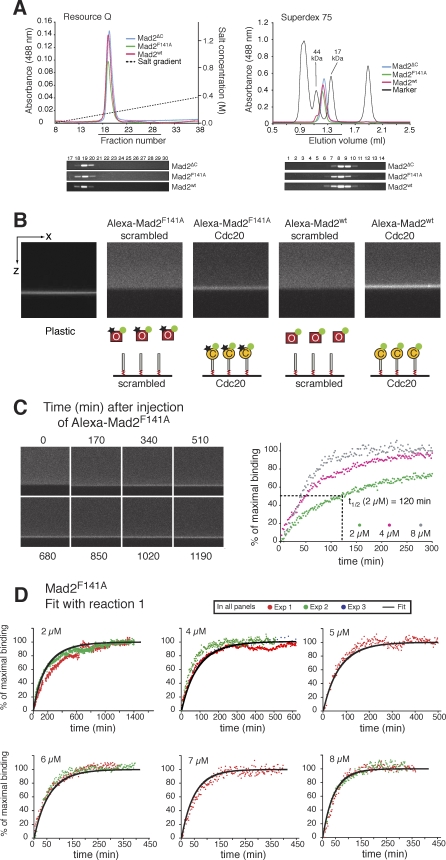
Kinetic Analysis for Rate Constants Determination of Mad2F141A
(A) The different Mad2 species used in the analysis retained their O-Mad2 conformation (left) and monomeric state (right) after covalent labelling with Alexa Fluor 488. After SDS-PAGE separation, the Alexa-labelled species were visualized under a UV transilluminator.(B) A flow chamber was built in which a biotinylated Cdc20 peptide (∼1 μM Cdc20, measured as the moles of peptide bound onto the surface divided by the volume of the chamber in litres; Figure S4) is immobilized onto the bottom surface through a biotin-streptavidin interaction. After addition of fluorescent Mad2, bound Mad2 can be visualized. The montage shows the specificity of the binding reaction. A black star characterizes Mad1F141 as opposed to Mad2wt; red squares indicate O-Mad2; yellow circles indicate C-Mad2; and a green dot represents a fluorescent label.(C) Real-time binding experiment using Alexa-Mad2F141A. The experiment was carried out at several Mad2 concentrations as indicated in the plot.(D) Fitting of the binding experiment with reaction 1 of Table S1. Parameters that gave the best fitting are reported in Table I. The fitting was carried out contemporarily on all available curves and at different concentrations as described in Text S1. As for the goodness of the fit, see Text S1 and Figure S5.